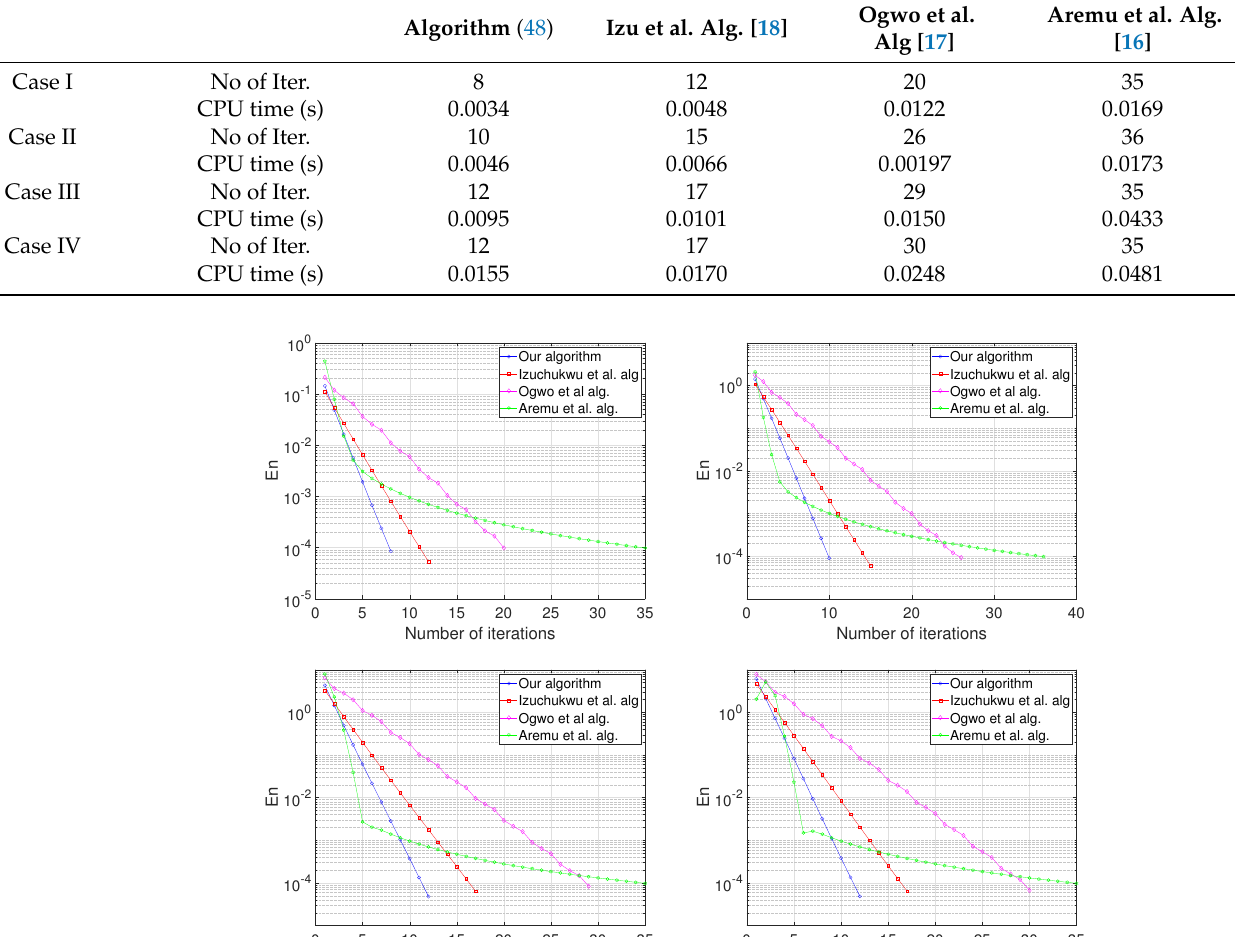
Figure 1. Example 1, ( Top Left ): Case I; ( Top Right ): Case II; ( Bottom Left ): Case III; ( Bottom Right